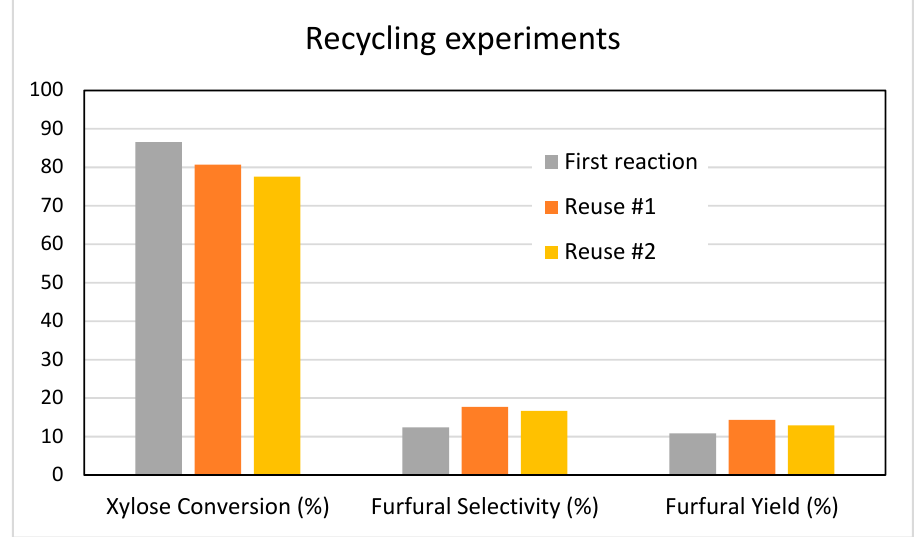
Figure 11. Conversion, selectivity and yield to furfural obtained during the dehydration of xylose on MgZr3-SG catalyst and two subsequent reuses. Reaction conditions: 0.1 g of catalyst, 20 mL of biphasic reaction mixture (water / toluene), 150 °C, 3 h reaction.